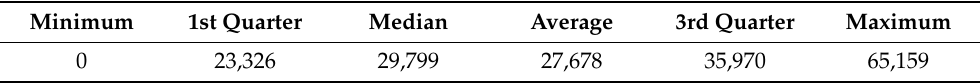
Table 1. Statistical analysis for general network traffic.